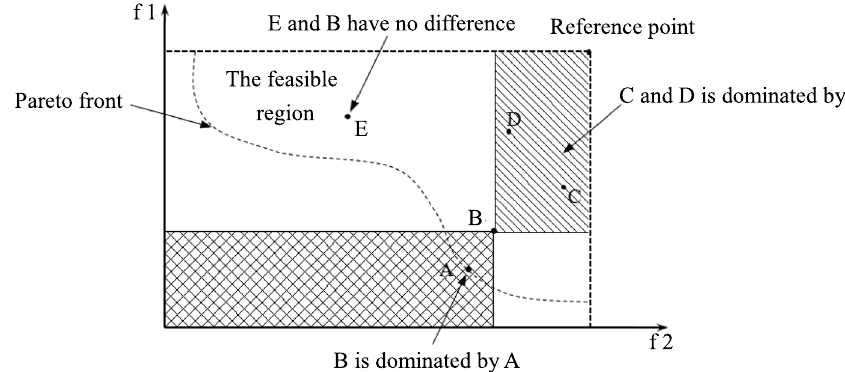
Fig. 7 The schematic diagram of concepts of Pareto dominance and Pareto front